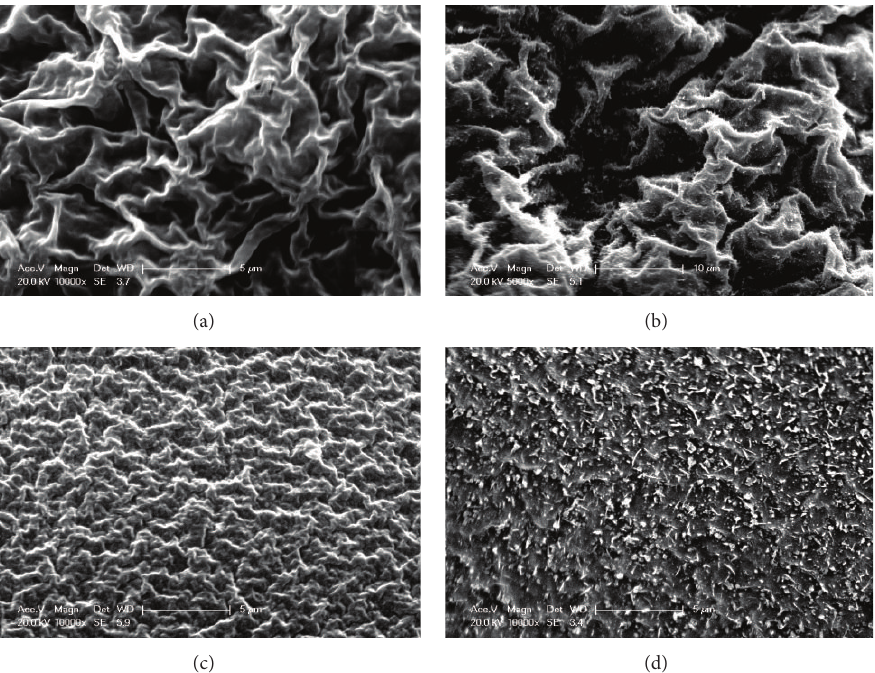
Figure 3: SEM images of resins before and after 𝜀 -PL adsorption. (a) D155, before adsorption; (b) D155, after adsorption; (c) HZD-3B, before adsorption; (d) HZD-3B, after adsorption.